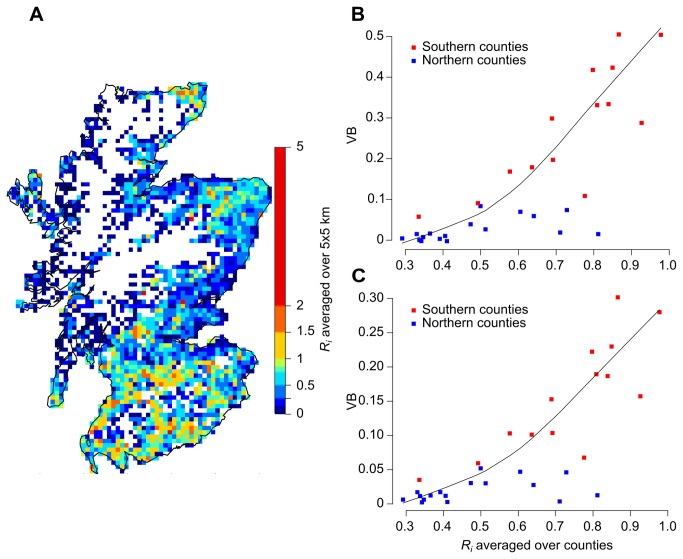
Influence of R
i on the benefit of the vaccination policy.Spatial distribution of the farm-level basic reproductive ratio, R
i (A) and its relation with the FMD vaccination benefit (VB) in Scotland. Vaccination benefit was measured based on the number of infected premises (B) and the epidemic duration (C) in the situation where 1 premise was infected at first detection (early detection). Values of R
i show in B and C are the average across all farms in each county. Note also that county-level estimates in B and C were grouped into the two areas as defined in this study (Figure 2). The colour scale used in the map shows the average value in a 5 × 5 km grid lattice. Estimates of R
i were computed based on the Scottish Agricultural Census June 2011 and using the method described in [15]. Solid curve in B and C represents the smooth fit to better visualize trends in the data set. The fit was generated using the locally weighted scatter plot smoother (LOWESS) method.